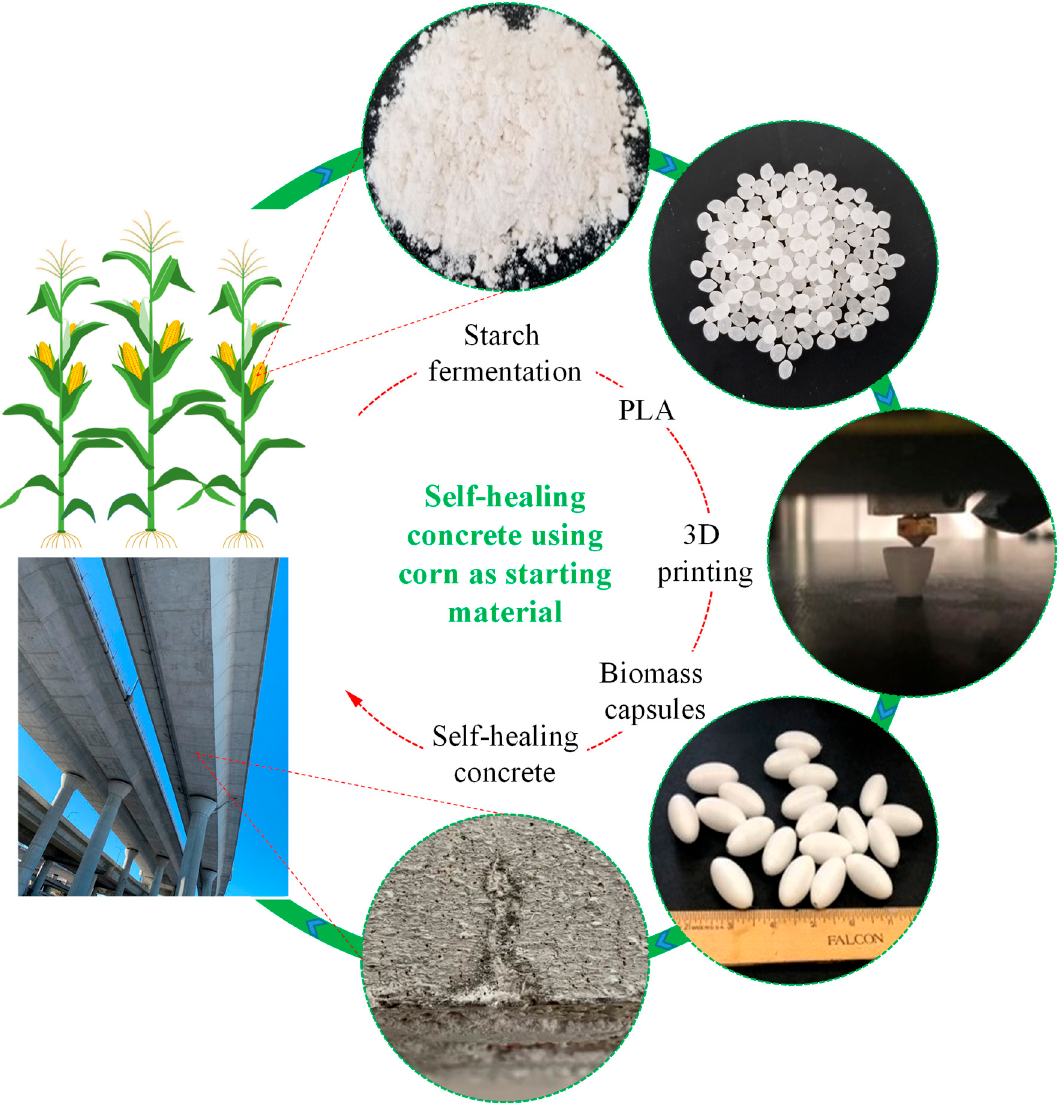
Figure 1. Schematic diagram of self-healing concrete using biodegradable corn as starting material. In this study, to leverage the physical and chemical features of PLA, capsules with different dimensions and geometry shapes were manufactured through 3D printing to